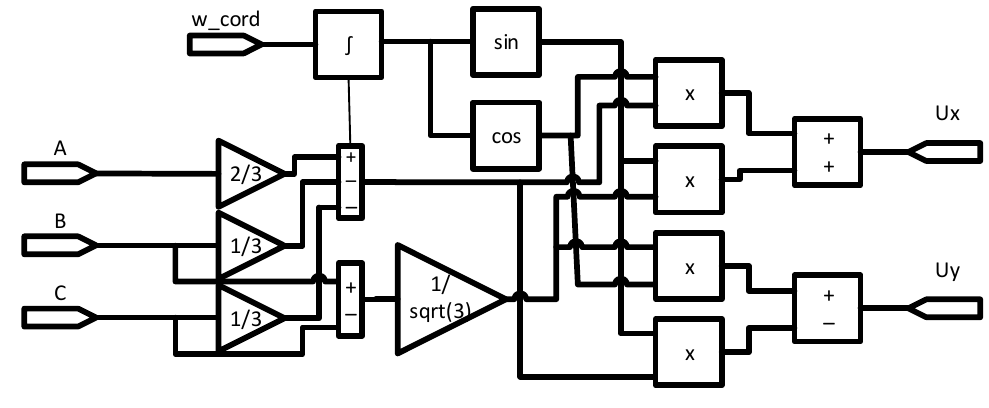
Figure 3. Conversion of supply voltage.